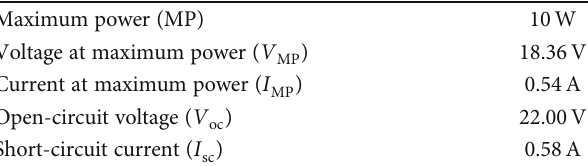
Figure 7: Electrical schematic of the designed SCC device. Table 1: Speci fi cations of the solar